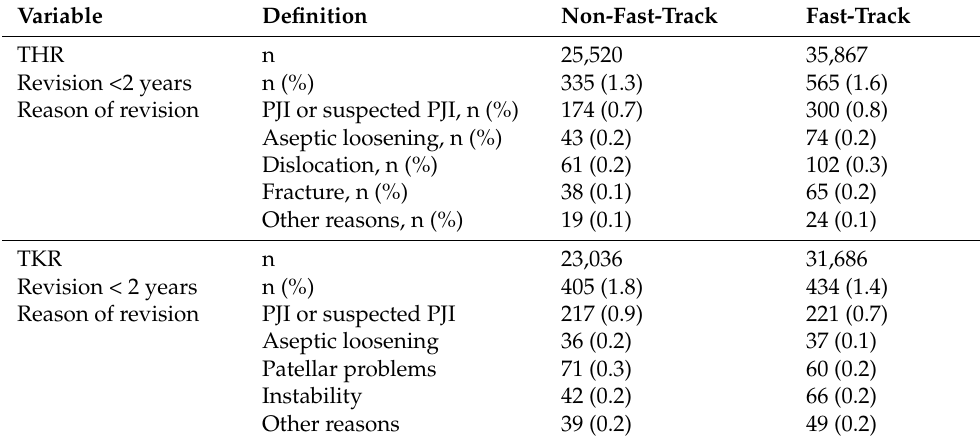
Table 2. Revisions within 2 years after THR and TKR operated 2011–2015.